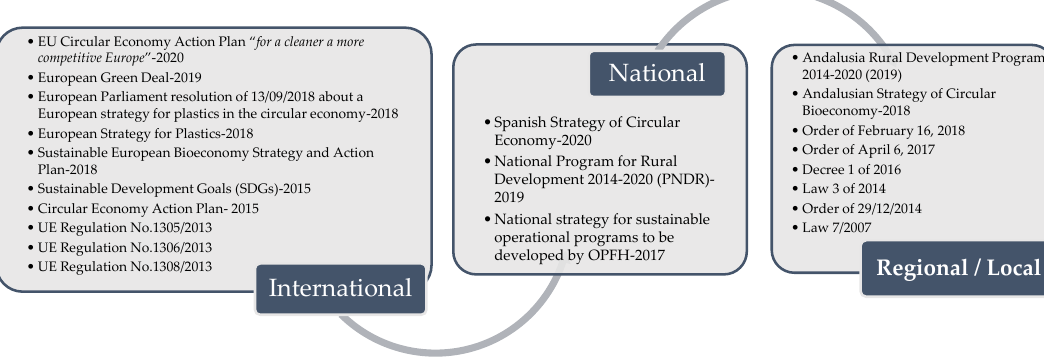
Figure 4. Policy framework, policy instruments and strategies promoting the use of biodegradable plastic (raffia). Source: Authorship.